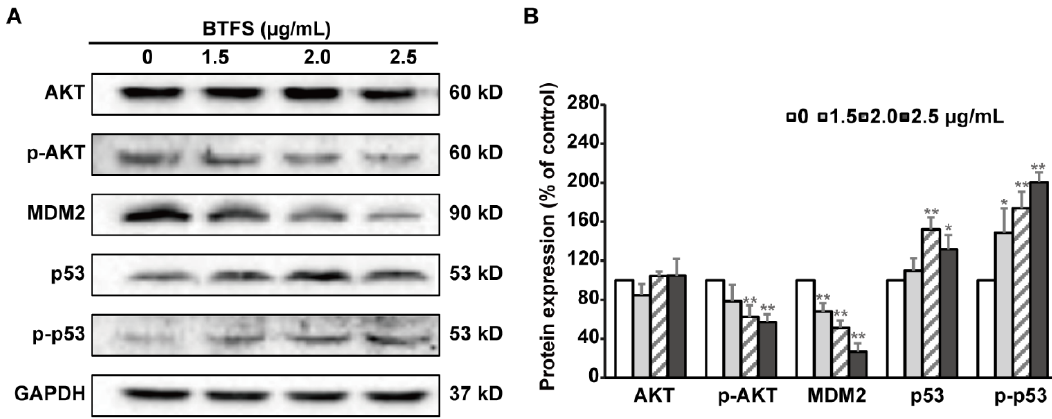
Figure 7. E ff ect of BTFS on AKT / MDM / P53 pathway related proteins. ( A ) Western blot image ( B ) Figure 7. Effect of BTFS on AKT/MDM/P53 pathway related proteins. ( A ) Western blot image ( B ) Statistical histogram of protein quantization. * p < 0.05; ** p < 0.01 versus Statistical histogram of protein quantization. * p < 0.05; ** p < 0.01 versus control.